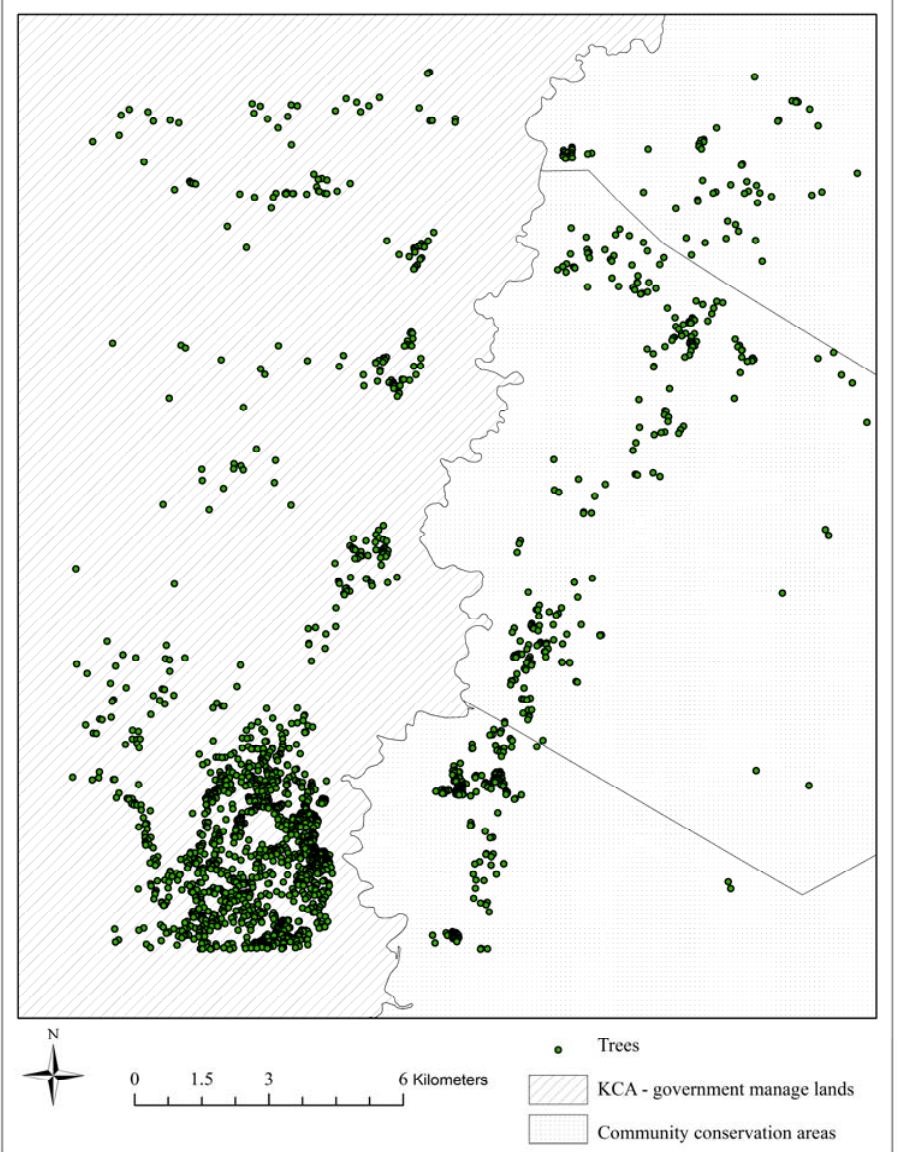
Figure 6. Distribution of trees within the diameter ≥ 12 m crown-size